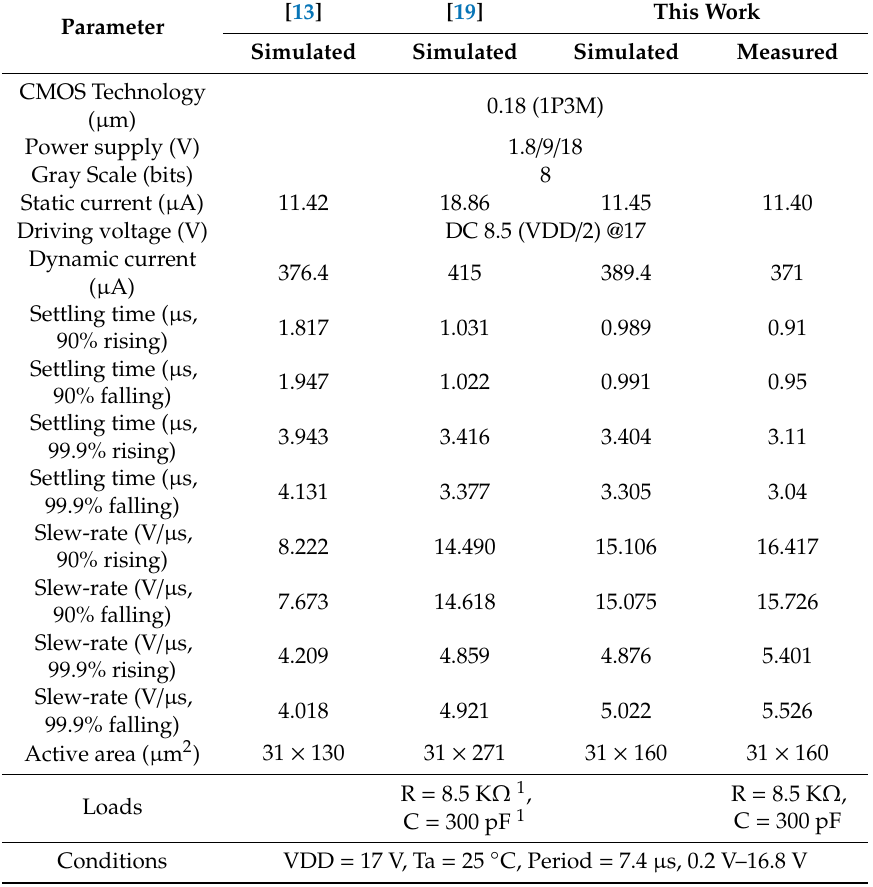
Table 2. Performance comparison of bu ff er amplifiers with the same technology.